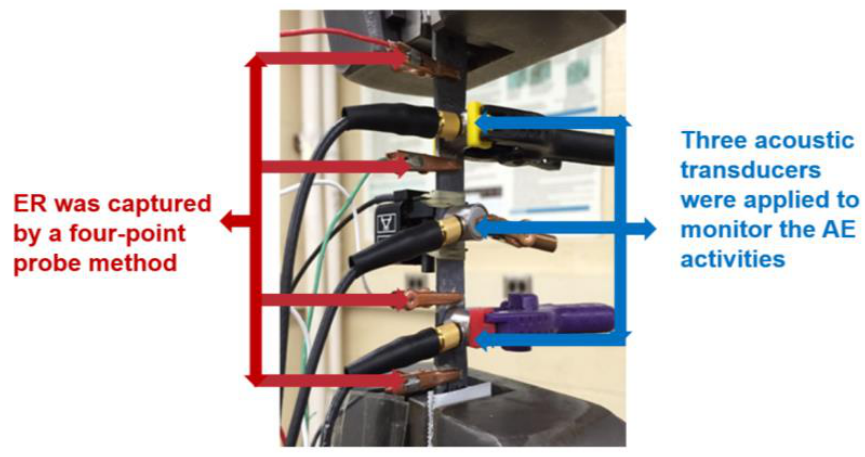
Figure 1. Test set-up for tensile fatigue tests showing three AE sensors and electrical resistance leads (not part of this study).